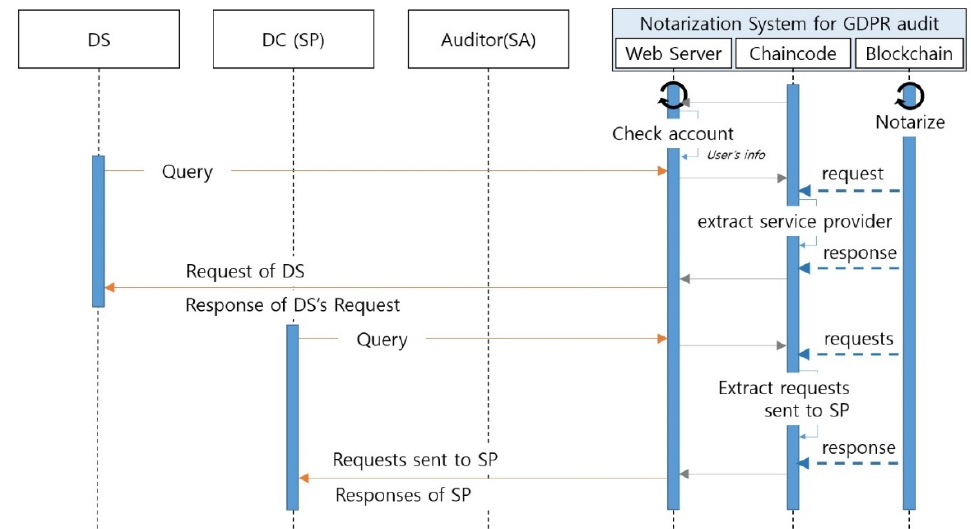
Figure 9. Transaction query process for the request and response for the processing of personal data.